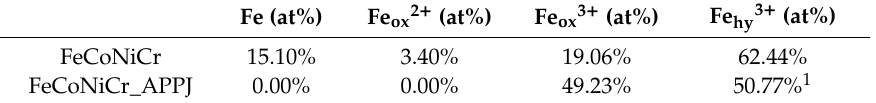
Figure 8. XPS Fe2p spectra of ( a ) FeCoNiCr and ( b ) APPJ-treated FeCoNiCr MEAs. Table 4. XPS Fe2p deconvoluted peak areal ratios from XPS spectra shown in Figure 8.